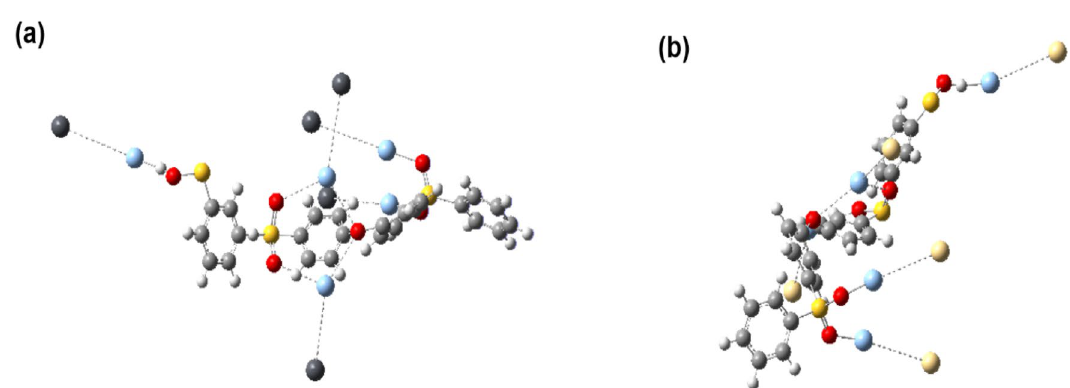
Figure 9. ( a ) Cd(II), and ( b ) Pb(II) binding to SP- 5 ENMs . Pb(II) and Cd(II) is depicted in deep grey color, sulfonate groups in magenta color, oxygen in red color, Ag in light green, and S in yellow